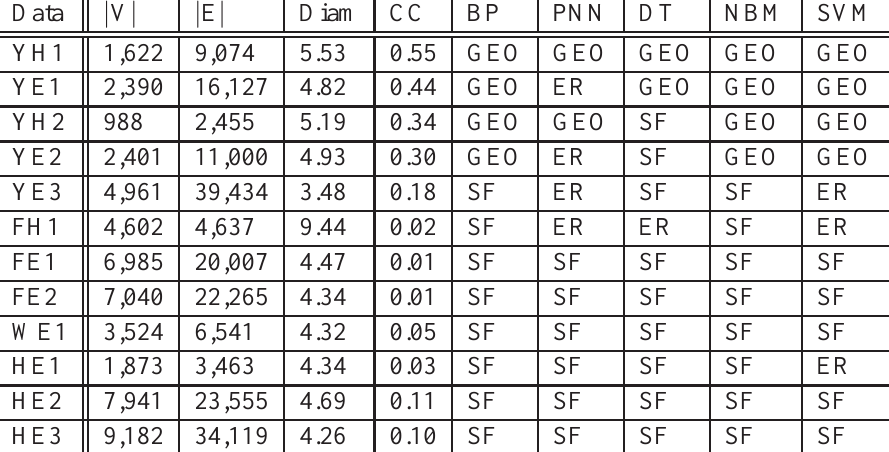
Table 1: The best-fitting network models (out of ER, GEO, and SF) predicted by the five classifiers (BP, PNN, DT, NBM, and SVM) for the 12 PPI networks. The PPI networks are presented in the first column, denoted by “Data.” Columns two to five contain the number of nodes (“ | V | ”), the number of edges (“ | E | ”), the average diameter (“Diam”), and the average clustering coefficient of a network (“CC”), respectively. Columns six to ten contain network models predicted by the five classifiers for each of the PPI